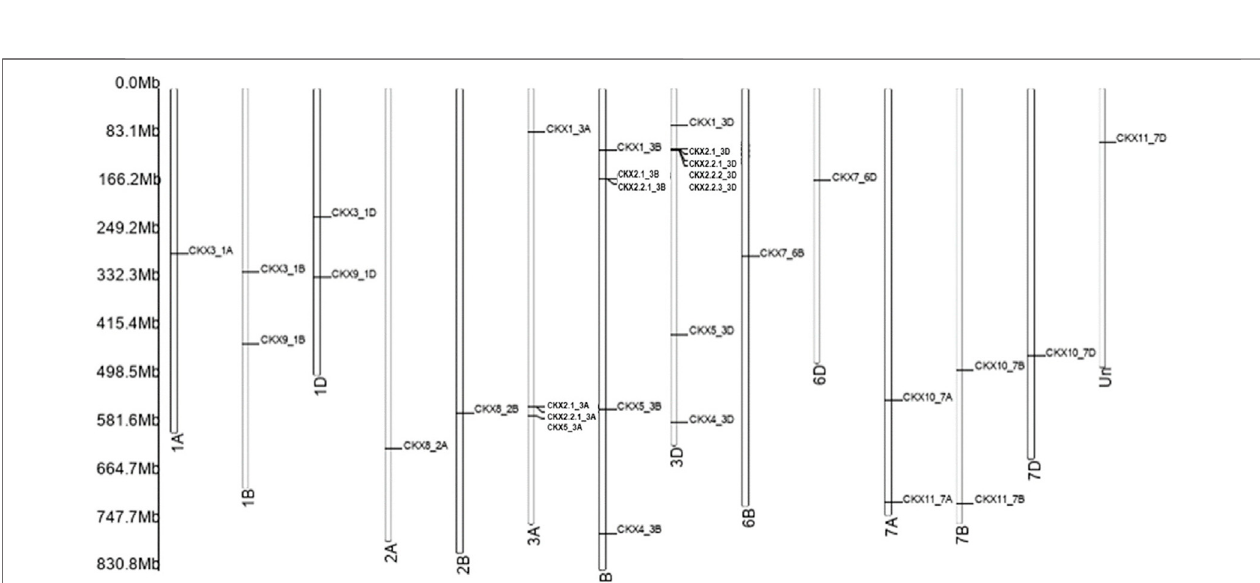
FIGURE 2 | Chromosomal locations of the CKX gene family in Triticum aestivum .